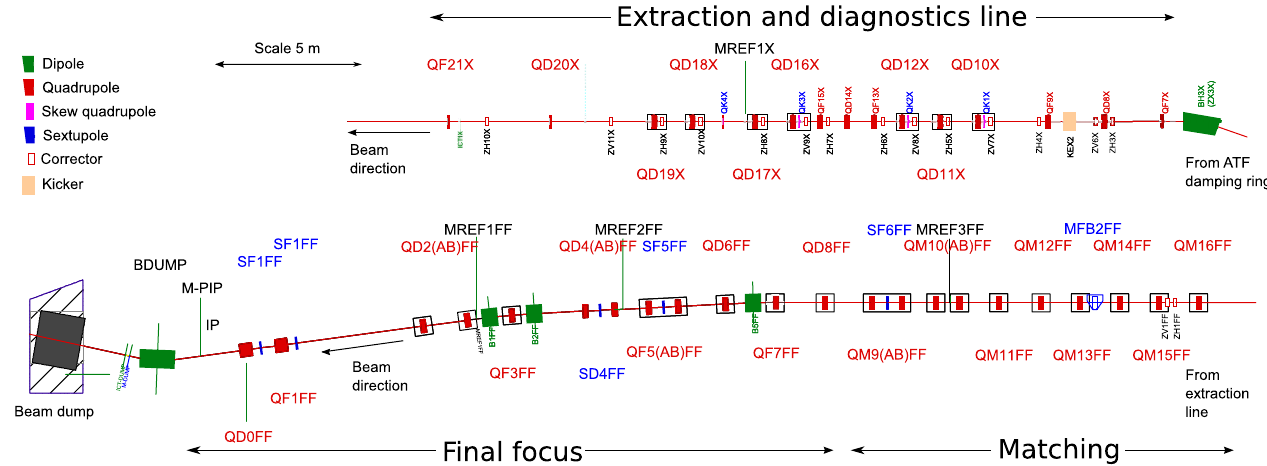
FIG. 1. ATF2 beam line, highlighting the quadrupoles containing